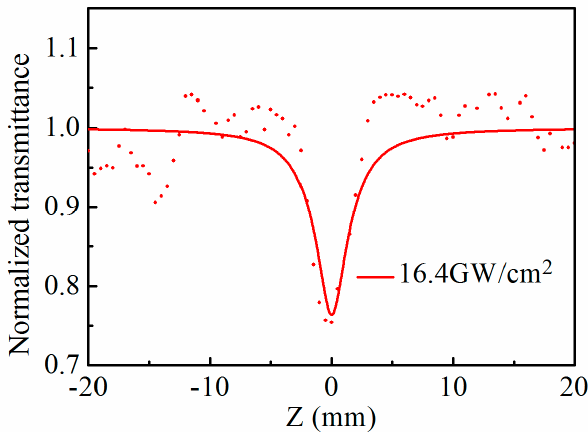
Figure 4. Normalized transmittance as a function of distance Z. Table 3. The nonlinear optical parameters of BTS crystal at λ = 532